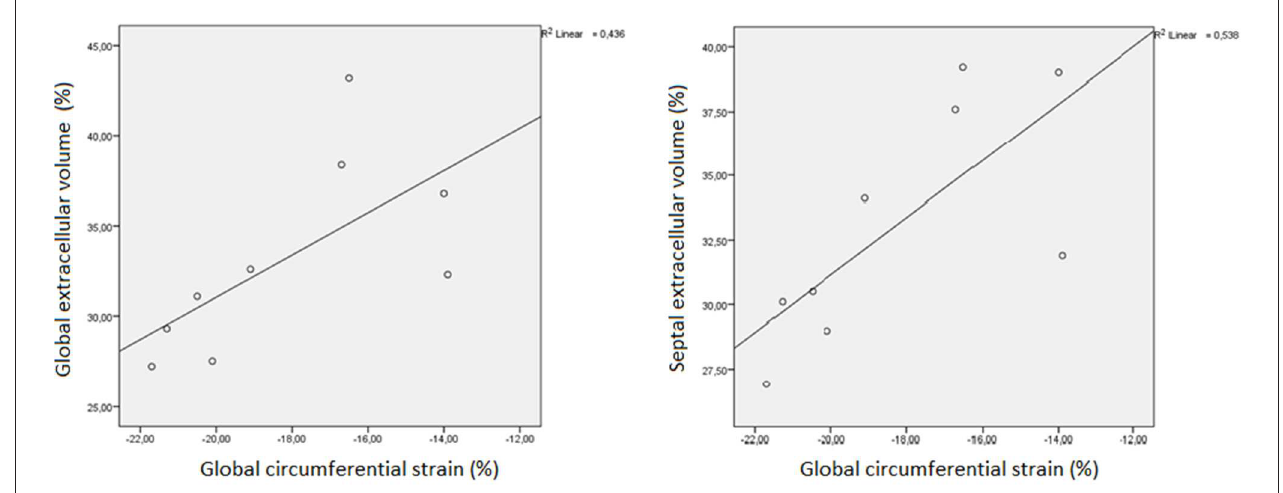
FIGURE 2 | Linear regression plot representing the correlation between both global (GECV) and septal extracellular volume (SECV) and global circumferential strain (GCS) in myotonic dystrophy patients.